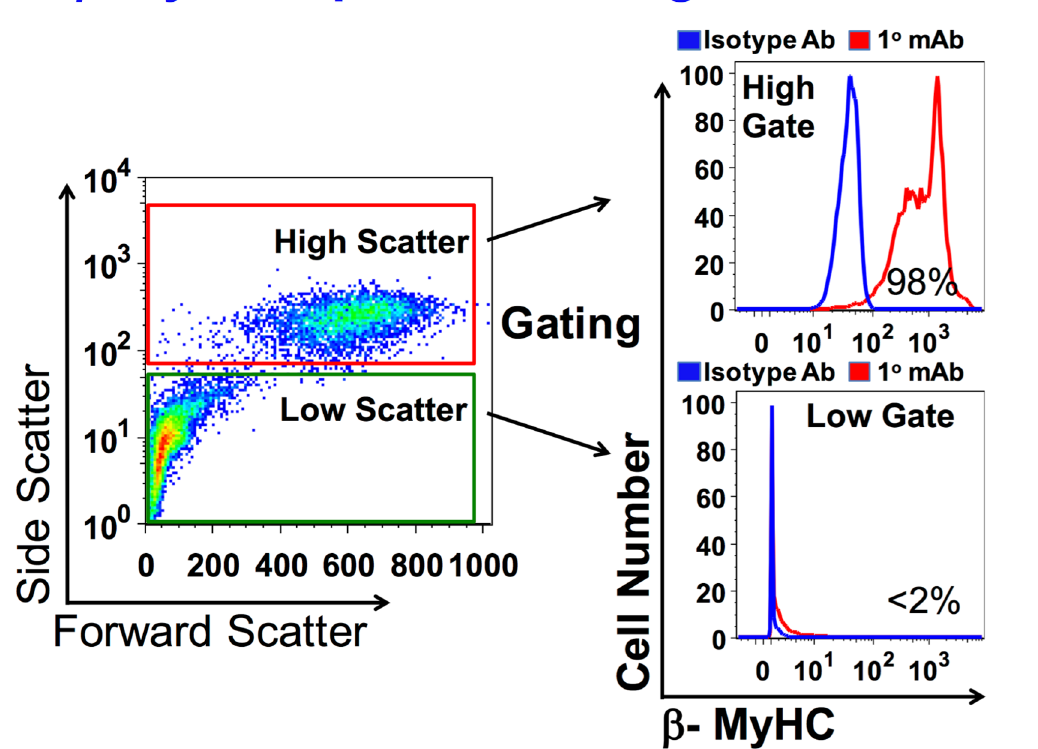
Fig 4. b-MyHC expression in high-scatter rabbit cells. A, Ventricularcells were preparedas describedin Fig 3A. Bivariate plots show the forward and side-scatter signature of nucleatedventricular cells. High-scatter(red box) and low- scatter (green box) sub-populations are gated accordinglyin histograms to the right. The cells were labeledwith NOQ7.5.4D mAb to identify the expressionof b-MyHC isoform. High scatter (top panel)and low scatter (bottom panel) cells in blue are stainedwith a non-specific IgG to determinebackground fluorescence. The cells in red are labeledwith anti-b-MyHCmAb. The percent in each plot correspond to the fraction of ventricular myocytes in the analogousscatter